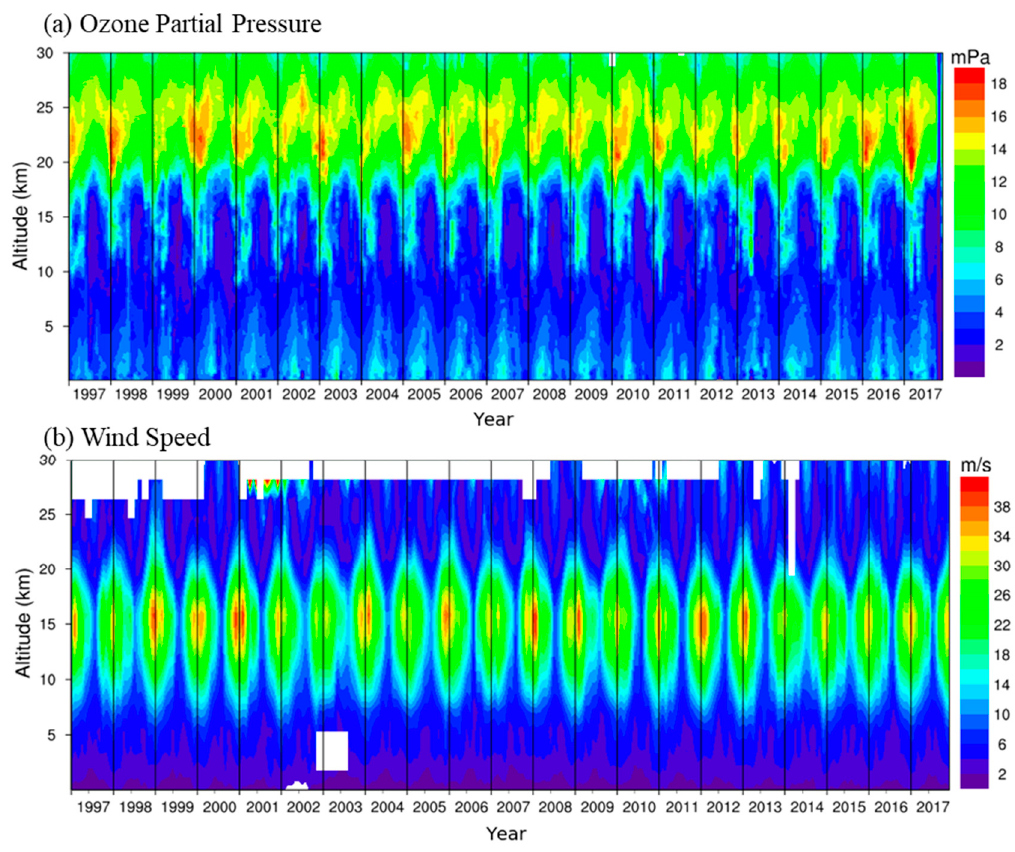
Figure 6. Monthly variation of time–altitude cross section of ( a ) ozone partial pressure and ( b ) wind speed at Pohang for 20 years (from 1997 to 2017).